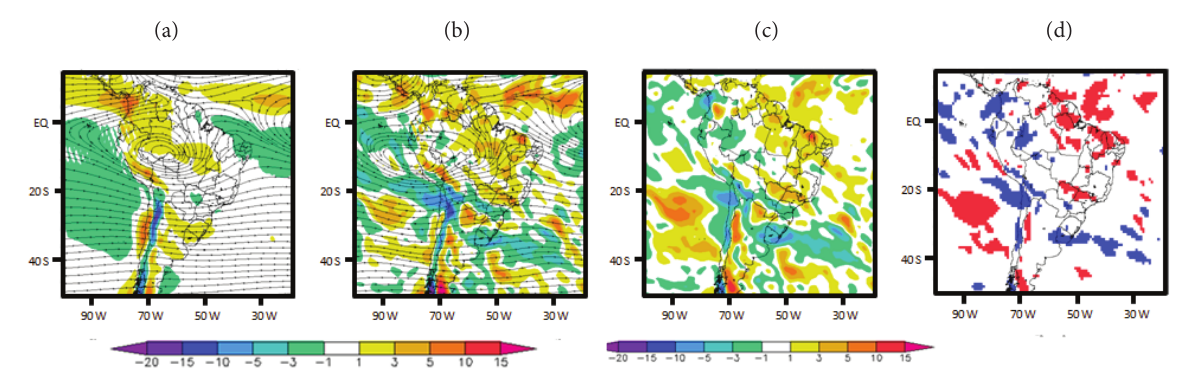
Figure 9. Atmospheric divergence at 250 hPa (10 –6 ·s –1 ) (a) for the dry quarter (SON) in the period 1979-2017, (b) for the 15 days with heavy precipitation and deep convection, and (c) the difference between them, i.e., “b” minus “a”. Data from the ERA- Interim reanalysis were used. (d) Differences are statistically significant at the 95% confidence level (Student’s t-test) over the shaded areas (blue: negative difference; red: positive). (a and b) Streamlines are shown.